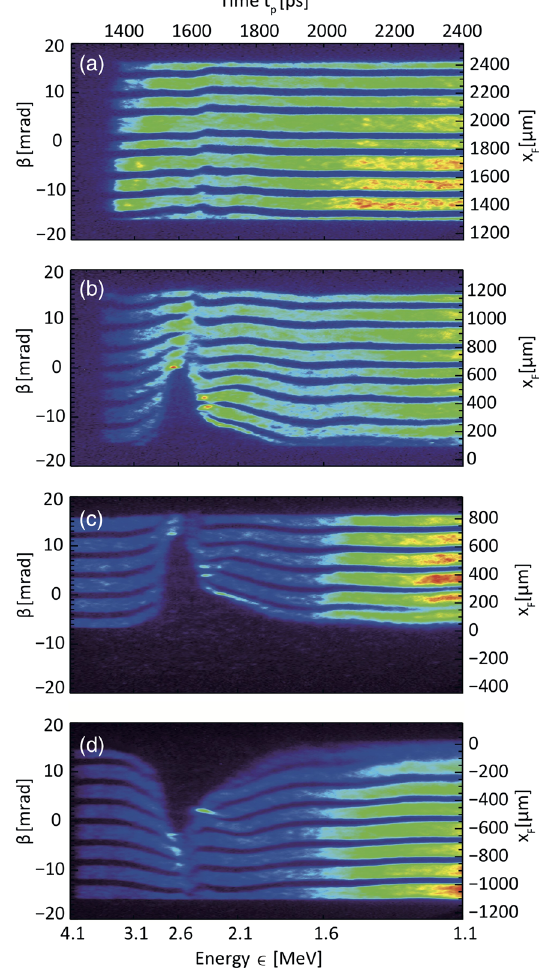
FIG. 3. Proton streak deflectometry measurements in trans- versal imaging configuration. The absolute x-position ( d x ) of the polymer foil was changed in consecutive